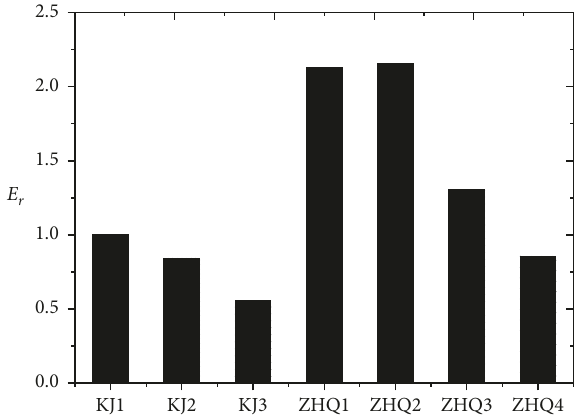
Figure 17: Relative accumulated energy